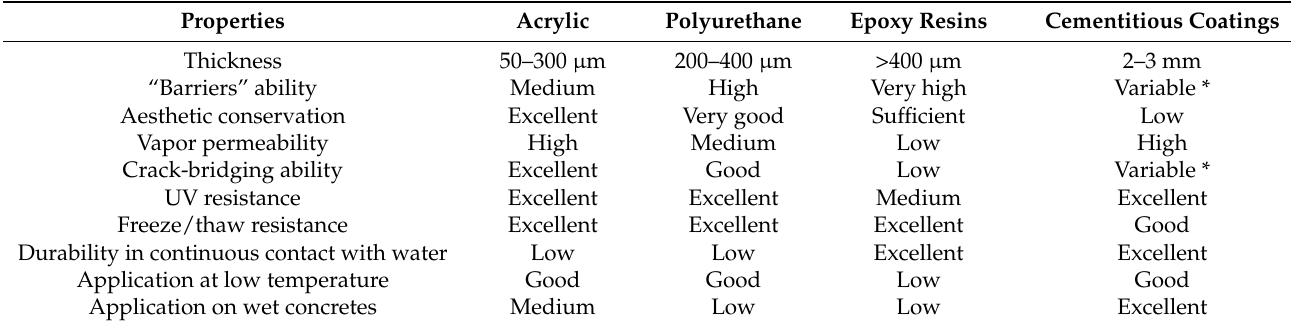
Table 1. Advantages and disadvantages of different surface treatments (classification according to the authors’ experience and by analyzing the principal products available on the European market and common best